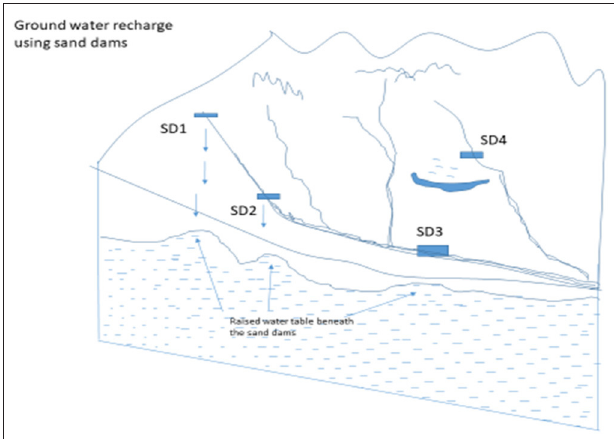
FIGURE 6 | Sand dams at different locations in a